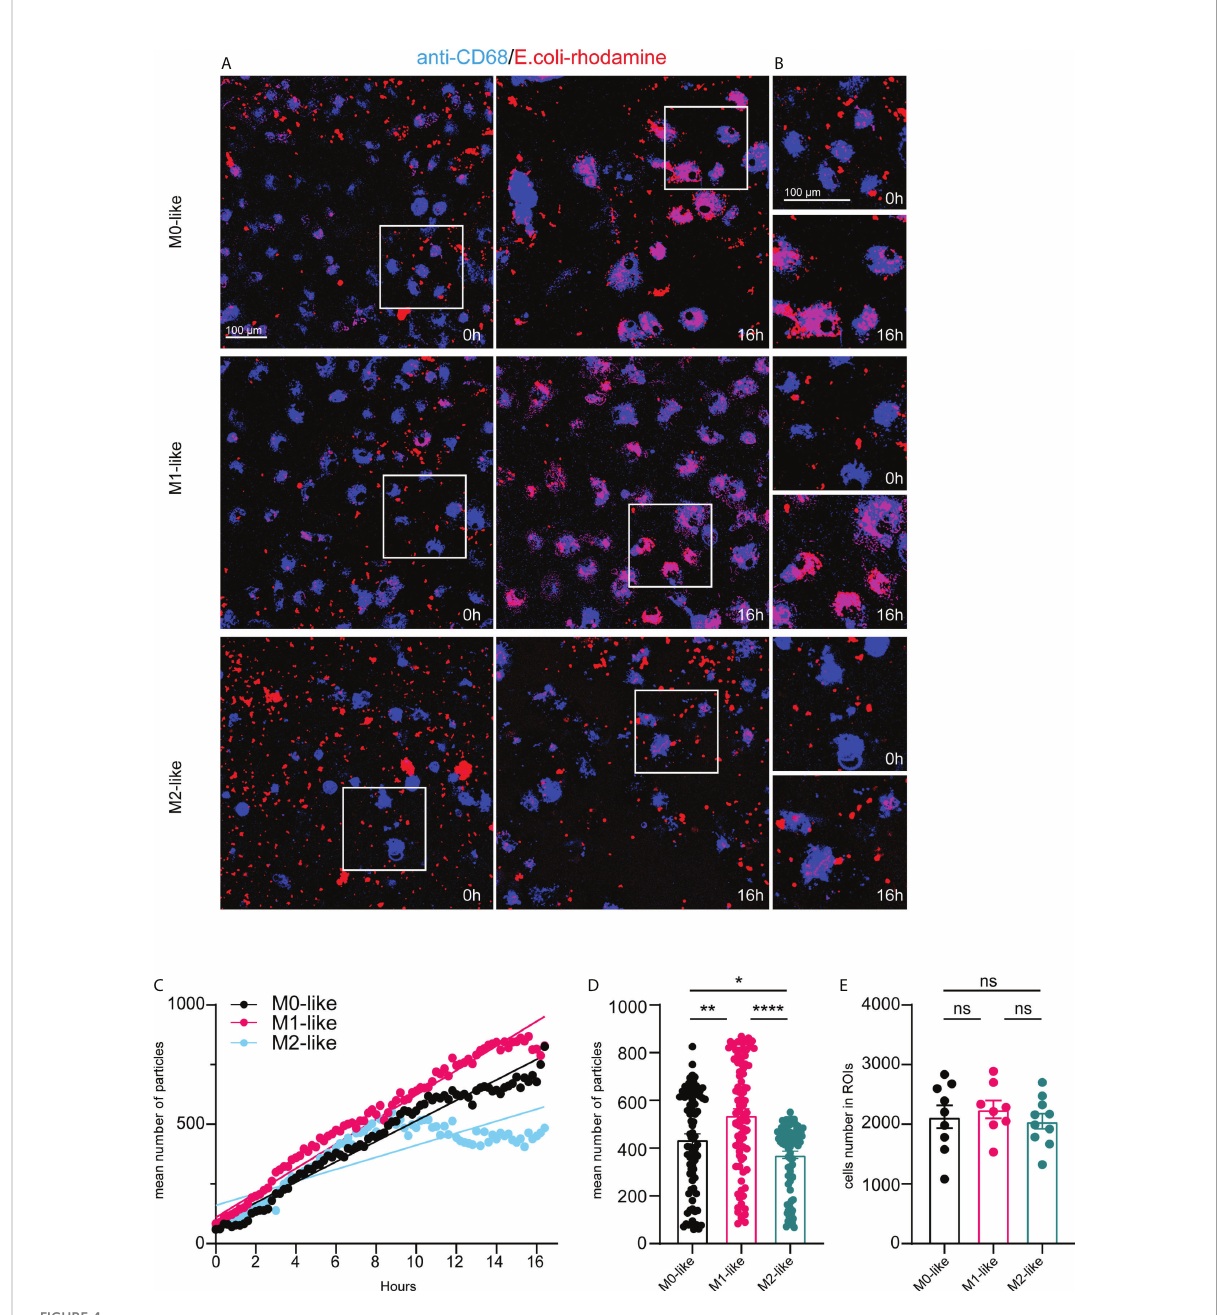
FIGURE 4 Microglia subtypes show substrate-speci fi c phagocytosis capacities and dynamics for E.coli particles over 16 hours (A) Single frame images and (B) image enlargements from live imaging movies of anti-CD68 live-immunolabelled microglia (blue) after addition of E.coli-rhodamine particles (red) at time-points 0h and 16h, scale bar, 100µm. Note pronounced E.coli particle accumulation in M0- and M1- but not in M2-like microglia at 16h after addition of E.coli particles. (C) Time-series plot showing the mean number of E. coli-rhodamine particles internalized (averaged from 8-10 ROIs for each time interval) by microglia subtypes over 16 hours. Simple linear regression calculation indicate different slopes of phagocytic capacities of M0- (black) (r 2 : 0,6902, p < 0,0001), M1- (pink) (r 2 : 0,5364, p < 0,0001), and M2-like (cyan) (r 2 : 0,3691, p < 0,0001), respectively. Note that M2-like microglia discontinued internalization at about 9 hours after addition of E.coli particles. (D) Mean number of internalized particles over 16 hours (averaged from 8-10 ROIs for each time interval). (E) Number of imaged anti-CD68 immunolabelled microglia encountering E.coli particles over 16 hours. Data are expressed as means ± SEM, one-way ANOVA ( post-hoc correction Holm-S ̌ ı ́ da ́ k test, *p < 0.05, **p < 0.01, ****p < 0.0001. ns, not signi fi